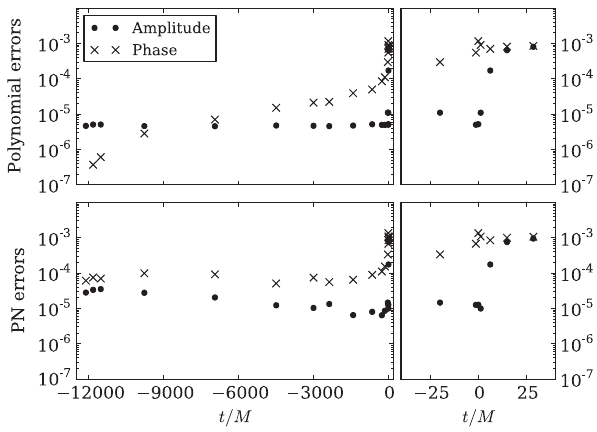
FIG. 8. The relative amplitude differences and phase differences of the least squares fits, as defined by Eqs. (26) and (27), maximized over the greedy mass ratios at each empirical time for our EOB example. The top panel shows these errors when using a polynomial least squares fit and the bottom panel when using a fitting function inspired by the post-Newtonian amplitude and phase. Both types of fits exhibit very low errors at all of the empirical